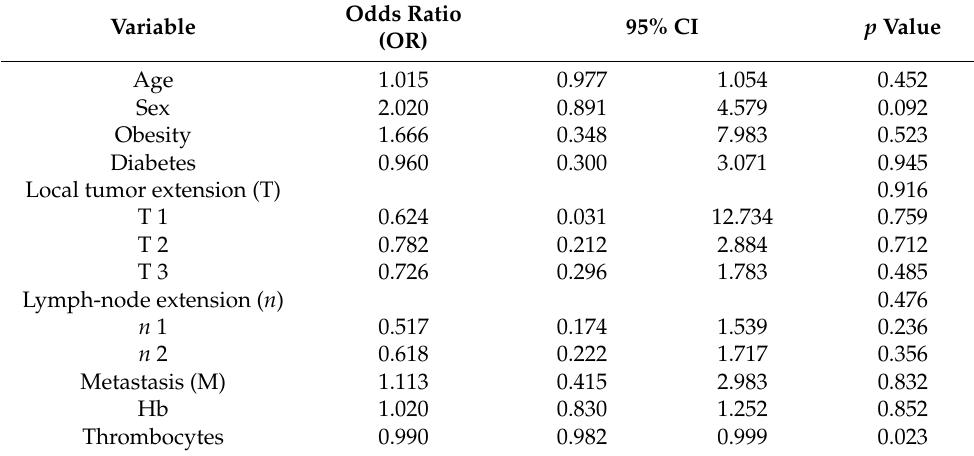
Table 6. Factors influencing overall surgical-complications rate in multivariate regression analysis.